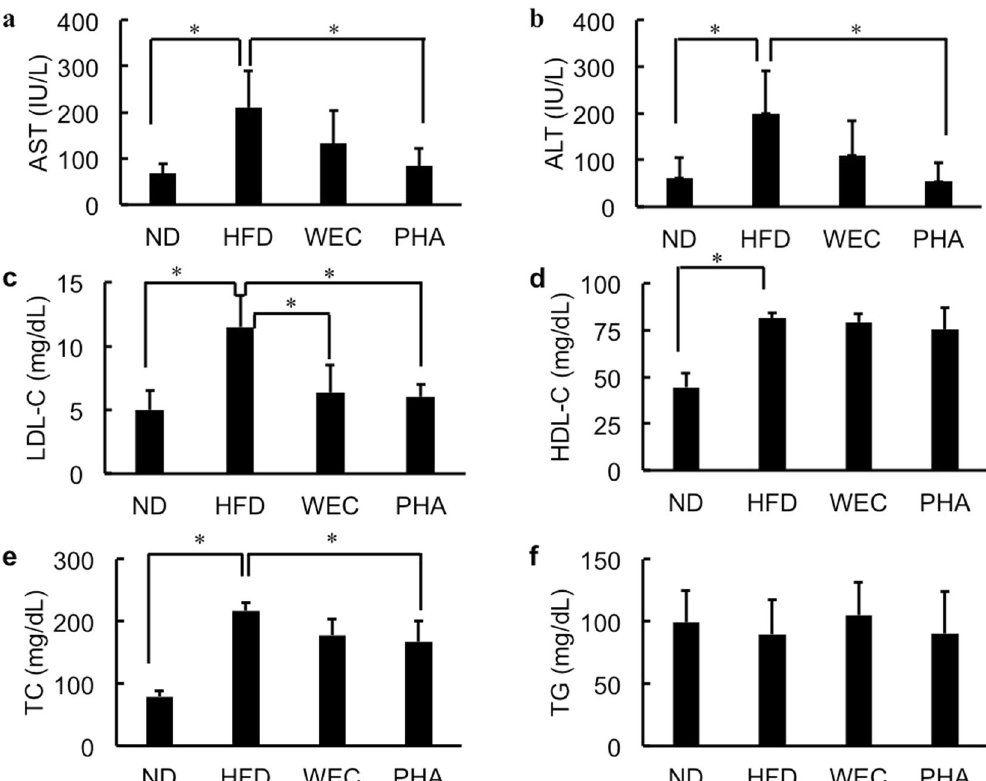
Fig. 2 The effects of WEC and PHA on plasma biochemical parameters. Plasma aspartate aminotransferase (AST) and alanine aminotransferase (ALT) activities ( a , b ) and the levels of low-density lipoprotein-cholesterol (LDL-C; c ), high-density lipoprotein-cholesterol (HDL-C; d ), total cholesterol (TC; e ), and triglyceride (TG; f ) in the normal diet-fed (ND), high-fat diet-fed (HFD), Chlorella pyrenoidosa water extract-treated (WEC), and phenethylamine-treated (PHA) groups. Data are represented as mean ± standard deviation ( n = 6). The means were compared using analysis of variance, followed by Dunnett ’ s test. * p < 0.05 vs. HFD